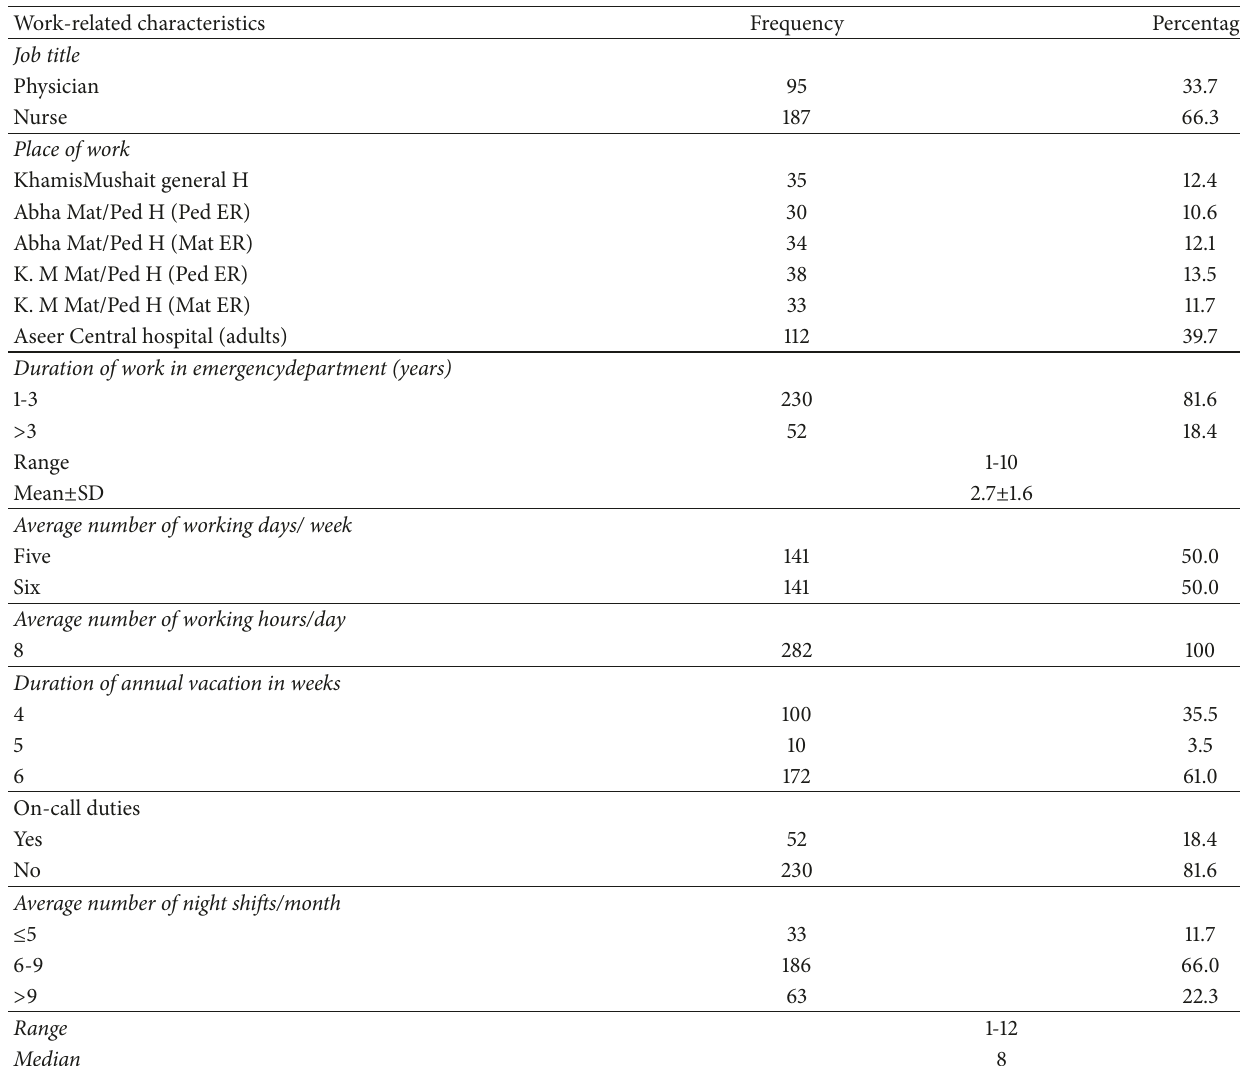
Table 2: Work-related characteristics of the emergency department healthcare